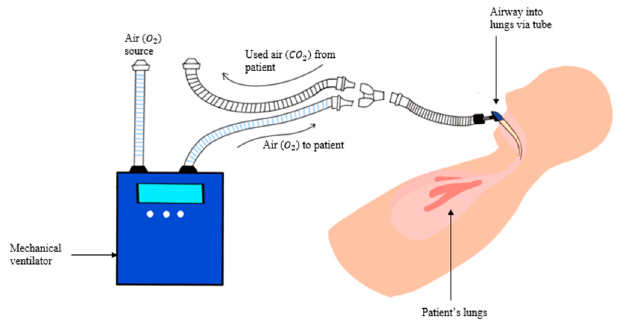
Figure 2. An example of a mechanical ventilator. The ventilator pulls air and extracts oxygen (O 2 ) from an external source. The patient receives the oxygen from the tube passing into the lungs. The mechanical ventilator also removes CO 2 from the patient’s lungs. The ventilator can be adjusted to control the rate and amount of ventilation.